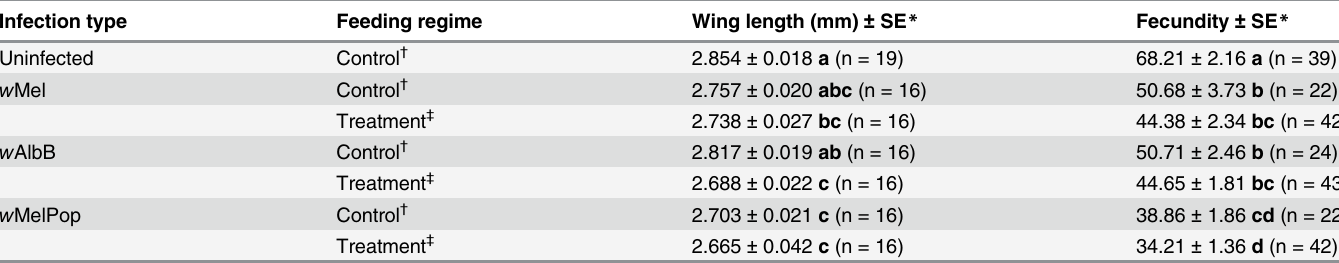
* Within a column, values with the same letter in bold are not signi fi cantly different from each other ( P > 0.05, by Tukey ’ s honest signi fi cant difference test)